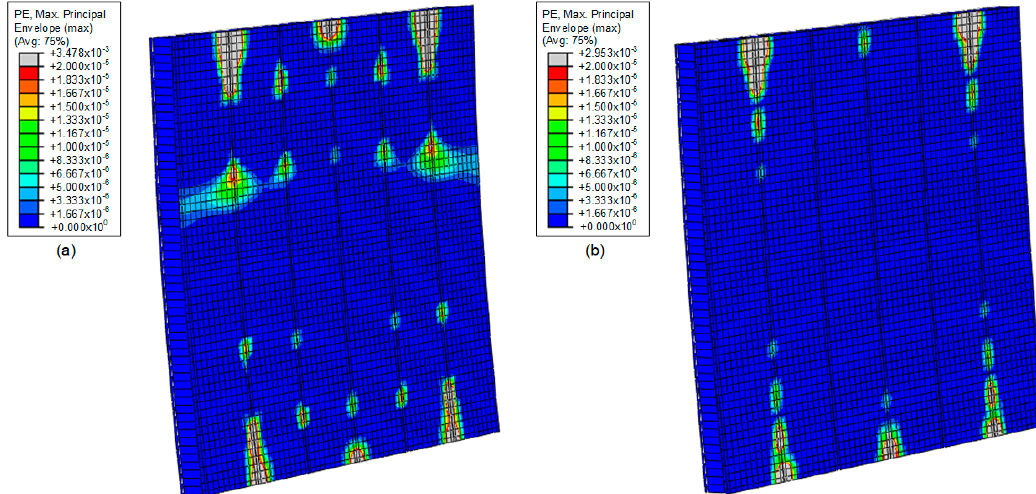
Figure 15. Contour plot of cracked regions, represented as maximum principle plastic strain, of the facing at a wind pressure of 2.0 kPa for element with single (S) connectors ( a ) and element with double (D) connectors ( b ).